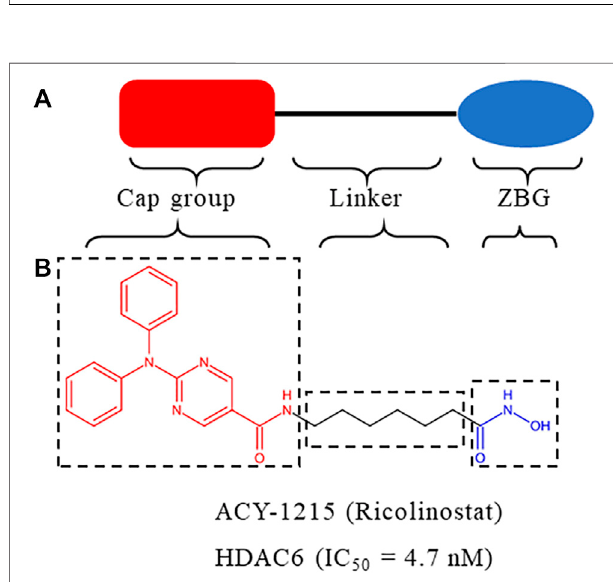
FIGURE2|(A) StructureofHDACsinhibitor. (B)